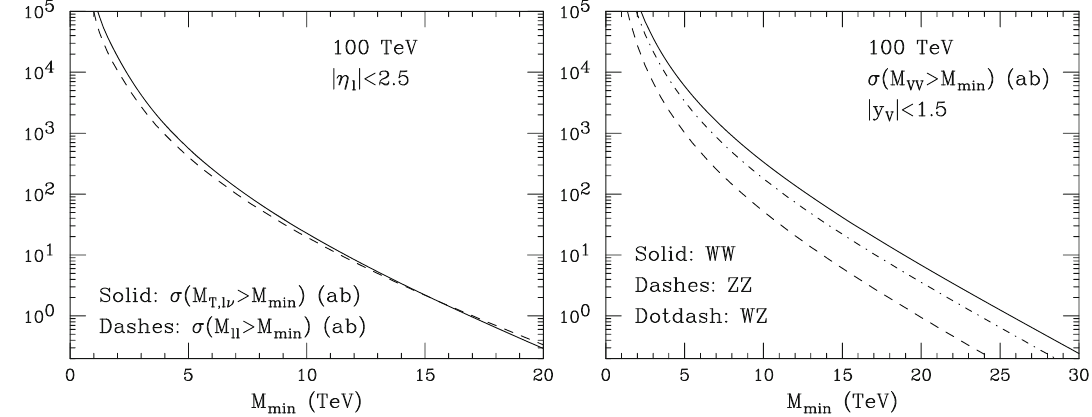
Fig. S.2 Left: integrated lepton transverse (dilepton) mass distribution in pp → W ∗ → (cid:13) ν (pp → Z ∗ / γ ∗ → (cid:13) + (cid:13) − ). One lepton family is included, with | η (cid:13) | < 2 . 5. Right: integrated invariant mass spectrum for the production of gauge boson pairs in the central kinematic range | y | < 1 . 5. No branching ratios included